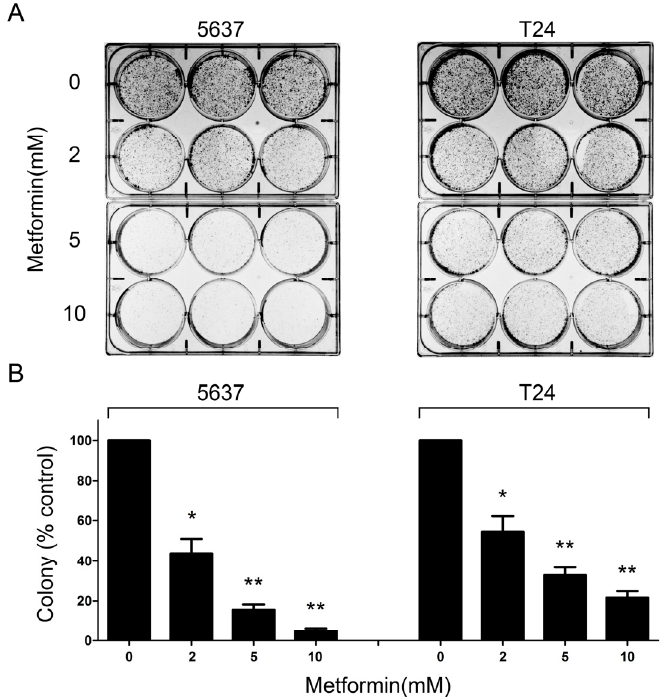
Figure 2. Metformin inhibits colony formation of bladder cancer cells. ( A ) 5637 and T24 cells grown in 6-well culture plates were treated with the indicated concentrations of metformin, every third days for two weeks. The pictures of 6-well culture plates with colonies were taken by a digital camera on day 14; and ( B ) The bar graph was obtained by calculating the percentages of colony numbers relative to controls, defined as 100%, measured by 1-D gel quantity software Quantity One. Columns, means of three independent experiments; bars, SEs. * p < 0.05 versus control; ** p < 0.01 versus